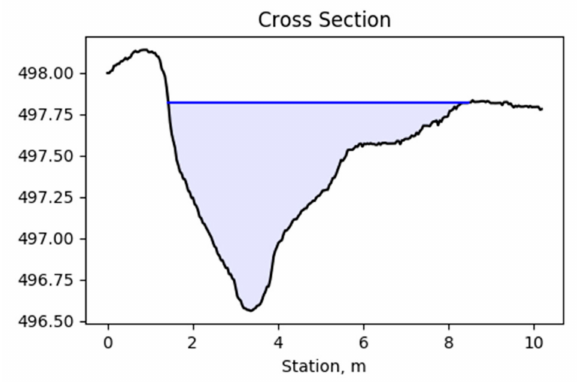
Figure 5. Cross-section in the lower section of the